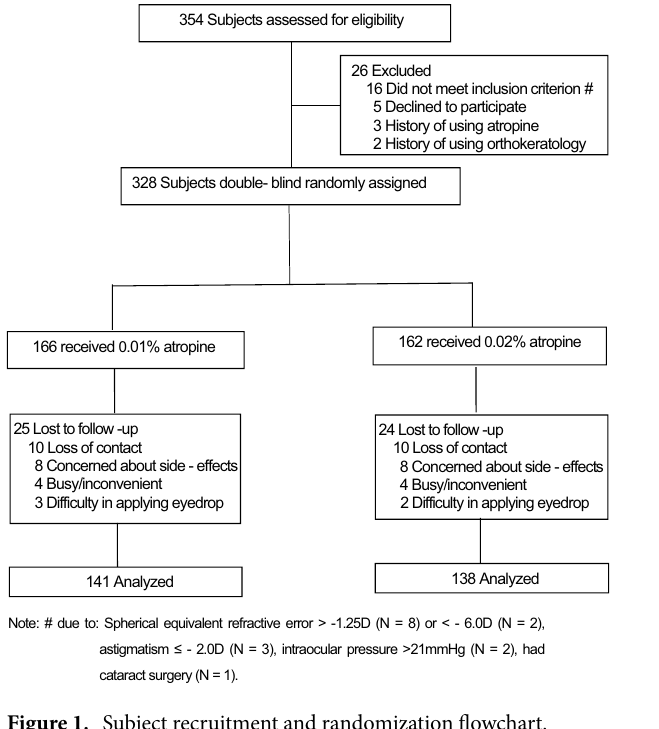
Figure 1. Subject recruitment and randomization